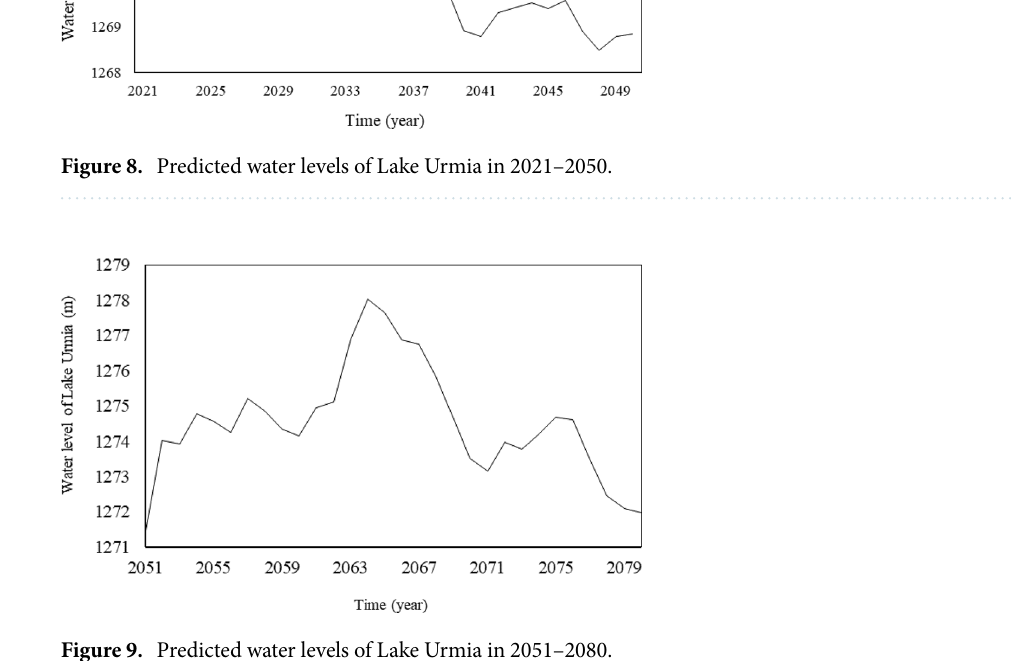
Figure 9. Predicted water levels of Lake Urmia in